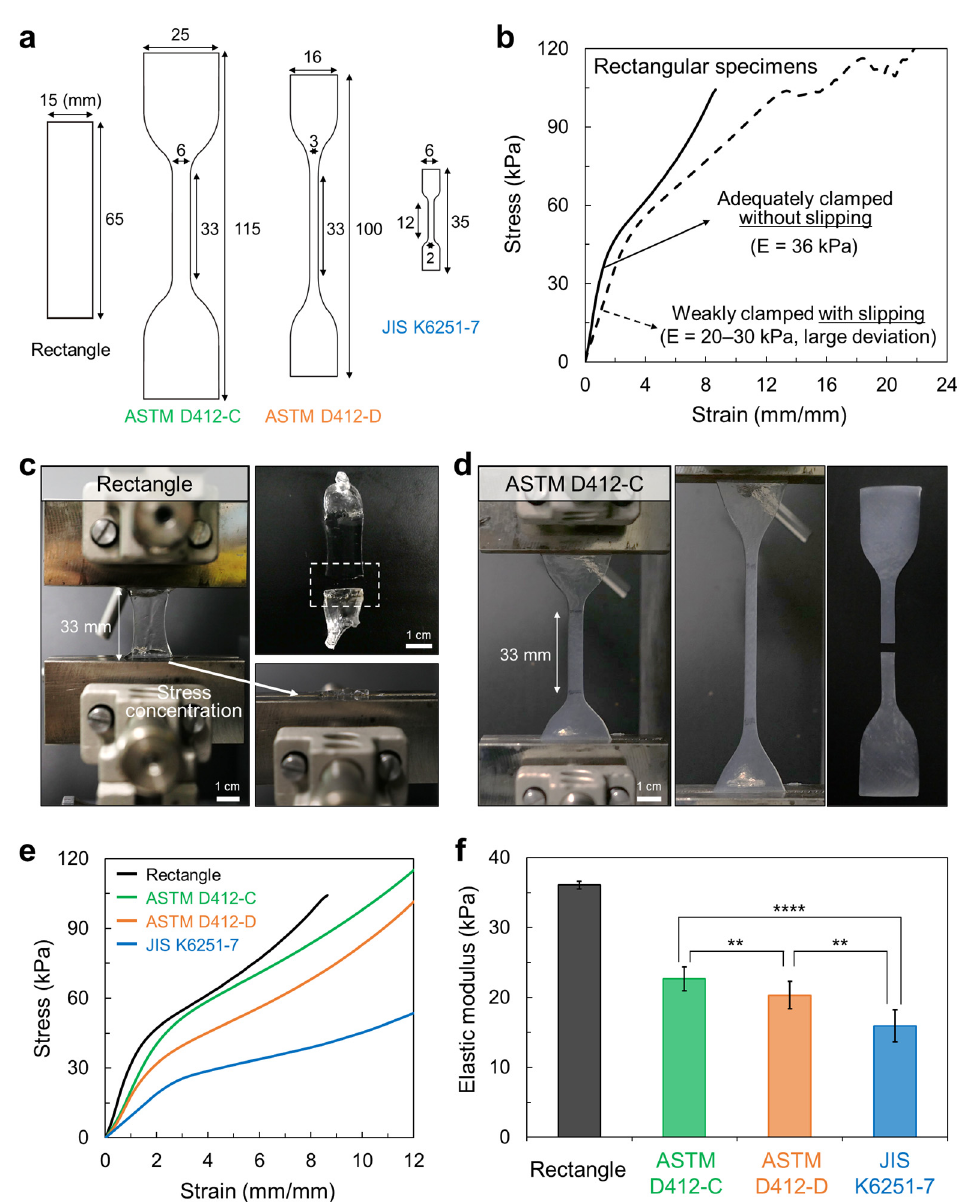
Figure 1. ( a ) Specimen dimensions of the rectangle, ASTM D412-C, ASTM D412-D, and JIS K6251-7. ( b ) Stress-strain curves for rectangular specimen under different clamping conditions. Photographs depicting ( c ) rectangular hydrogel and ( d ) ASTM D412-C hydrogel mounted in the testing machine and broken after the test. In the rectangular hydrogel, a stress concentration near the grip usually provokes an early fracture of the hydrogel (dashed box). ( e ) Stress-strain curve and ( f ) elastic moduli of the hydrogel with different shapes. ** p < 0.01; **** p < 0.0001.